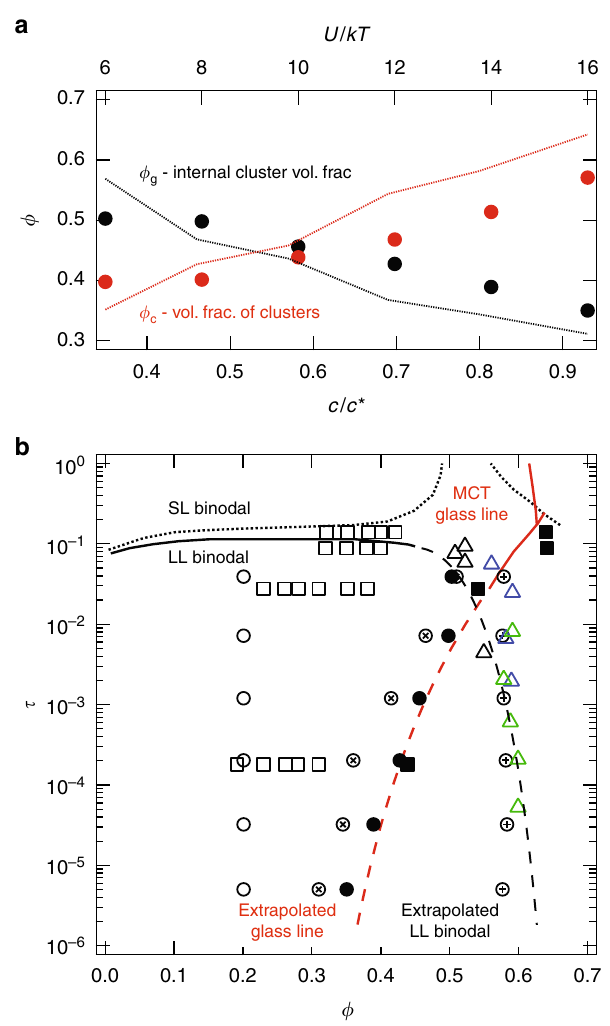
Fig. 4 The internal cluster particle concentration. a The cluster densities ϕ g (black) and volume fractions of clusters ϕ c (red) determined from simulations and application of the graph theory. The lines are approximations of ϕ g (black) and ϕ c (red) found by substituting the hard sphere equation of state into the Cauchy-Born theory with 〈 r 2 〉 = ξ 2 /15 and G ′ given by the simulation results. Nearly identical values are found when using the experimentally determined modulus. b Initial volume fraction and reduced temperature of gel samples (open circles) and cluster densities ϕ g determined in this work (closed circles, graph theory; circle-x, hard sphere equation of state). The square symbols reproduce the data of Ramakrishnan et al. 10 with open squares the experimentally measured particle volume fraction and closed squares the cluster densities inferred from application of the Cauchy-Born theory with the hard-sphere equation of state. The attractive and repulsive glass lines with a bilinear shift from the mode coupling theory (MCT) are drawn in solid red 35,36 while an extrapolation through the experimental data is indicated with the dashed red line. The AHS phase boundaries with the fl uid-solid coexistence lines for a / R g = 10 6 are given by short dashed black lines. Fluid- fl uid coexistence is indicated by the solid black line and its extrapolation by the dashed black line. The local volume fraction of particle-rich regions (shown as open circle-plus) is compared with values from ref. 9 : blue triangles are ϕ = 0.13 and δ = 0.059, green triangles are ϕ = 0.045 and δ = 0.018, and black triangles are ϕ = 0.045 and δ = 0.059, where δ is the range of